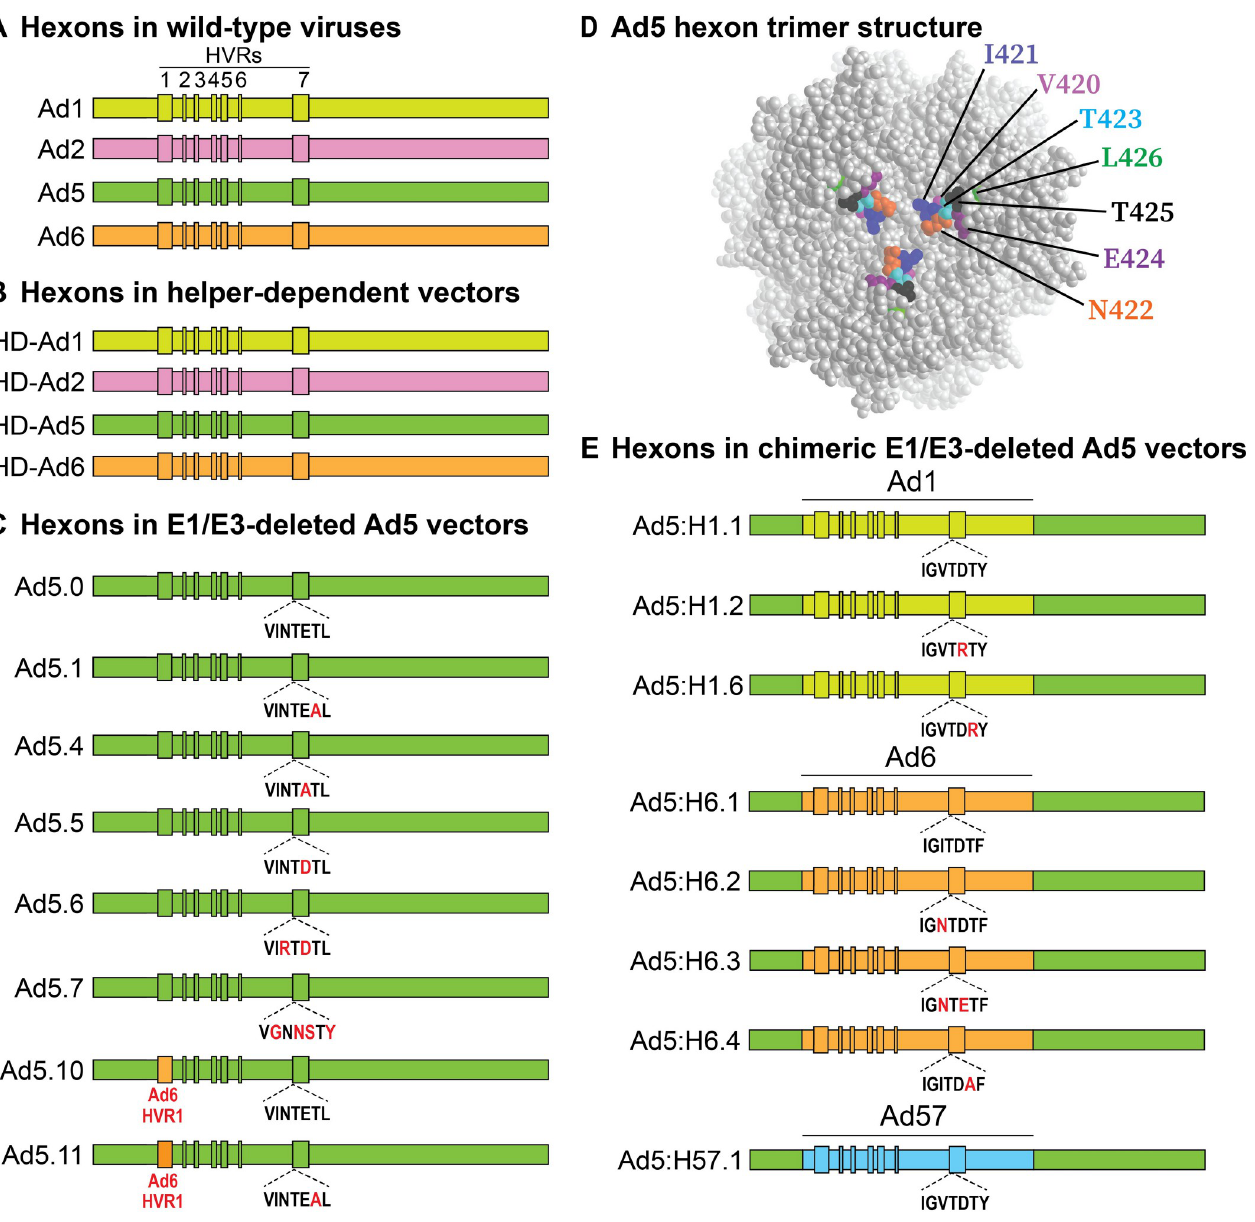
Fig 1. Hexons of the viruses and vectors used in this study. (A) Schematic of hexons in wild-type viruses. Each color represents a different serotype. The seven hexon hypervariable regions (HVRs) are indicated as boxes. (B) Hexons in HD vectors are identical to wild-type hexons. All HD-Ad vectors used in this study express luciferase. (C) Ad5.0 is an E1/E3-deleted Ad5 vector that expresses luciferase. We created additional vectors by site-directed mutagenesis in a short segment of HVR7 that is known to be important for Gla domain binding. Altered residues in HVR7 are shown in red. The mutations in Ad5.1 and Ad5.4 were first described by Doronin et al . (2012) [11], and the mutations in Ad5.7 were first described by Alba et al . (2009) [12]. For Ad5.10 and Ad5.11, the HVR1 region of Ad5 hexon was replaced with the HVR1 region of Ad6 hexon. (D) View of the outward-facing surface of the Ad5 hexon trimer (Protein Data Bank ID: 3TG7). The cavity in the center of the trimer contains the Gla domain binding site, and residues on the walls of this cavity affect Gla domain binding [1,5,11,12]. (E) Hexon-chimeric E1/E3-deleted Ad5 vectors that express luciferase. We replaced a section of the Ad5 hexon (residues 112–593) with the corresponding section from Ad1, Ad6 or Ad57 hexon. Remaining Ad5 hexon sequences are shown in green and are highly conserved among species C hexons (100% identity in residues 1–111, and 99.4% identity in residues 594–952). Altered residues in HVR7 are shown in red.